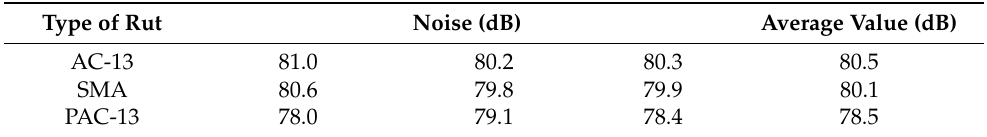
Table 9. Tire noise of various types of mixture.